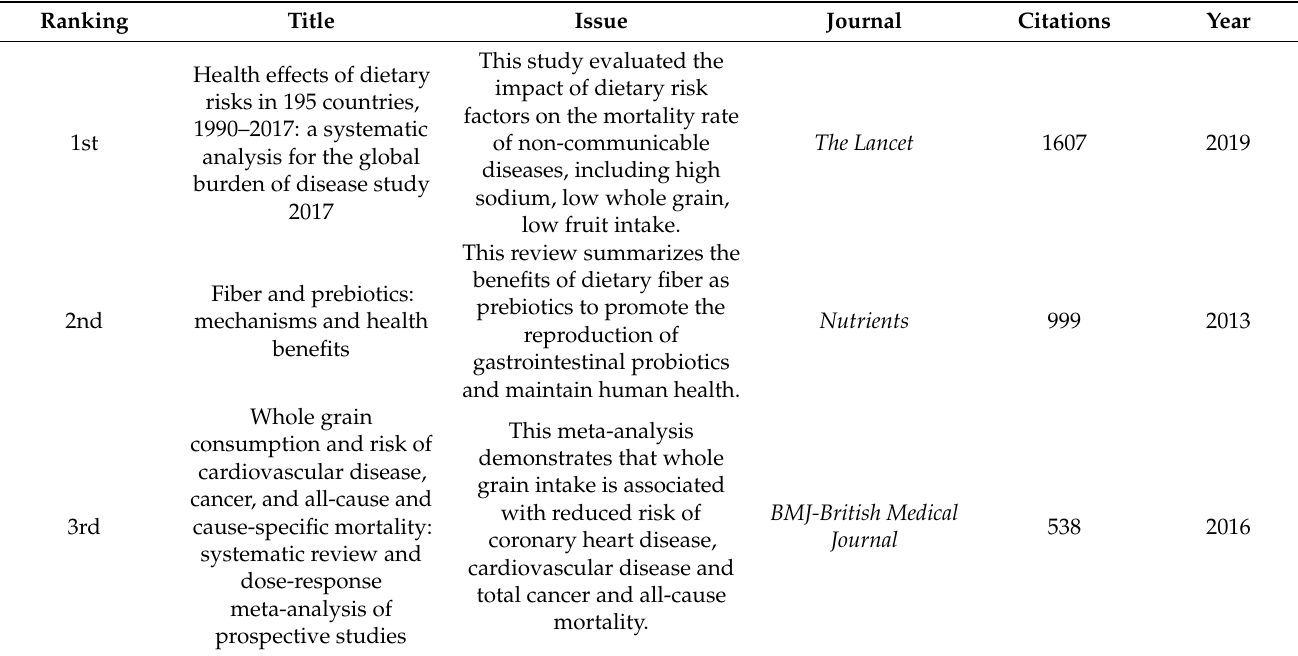
Table 2. Top 10 most cited articles in the whole grain health effect